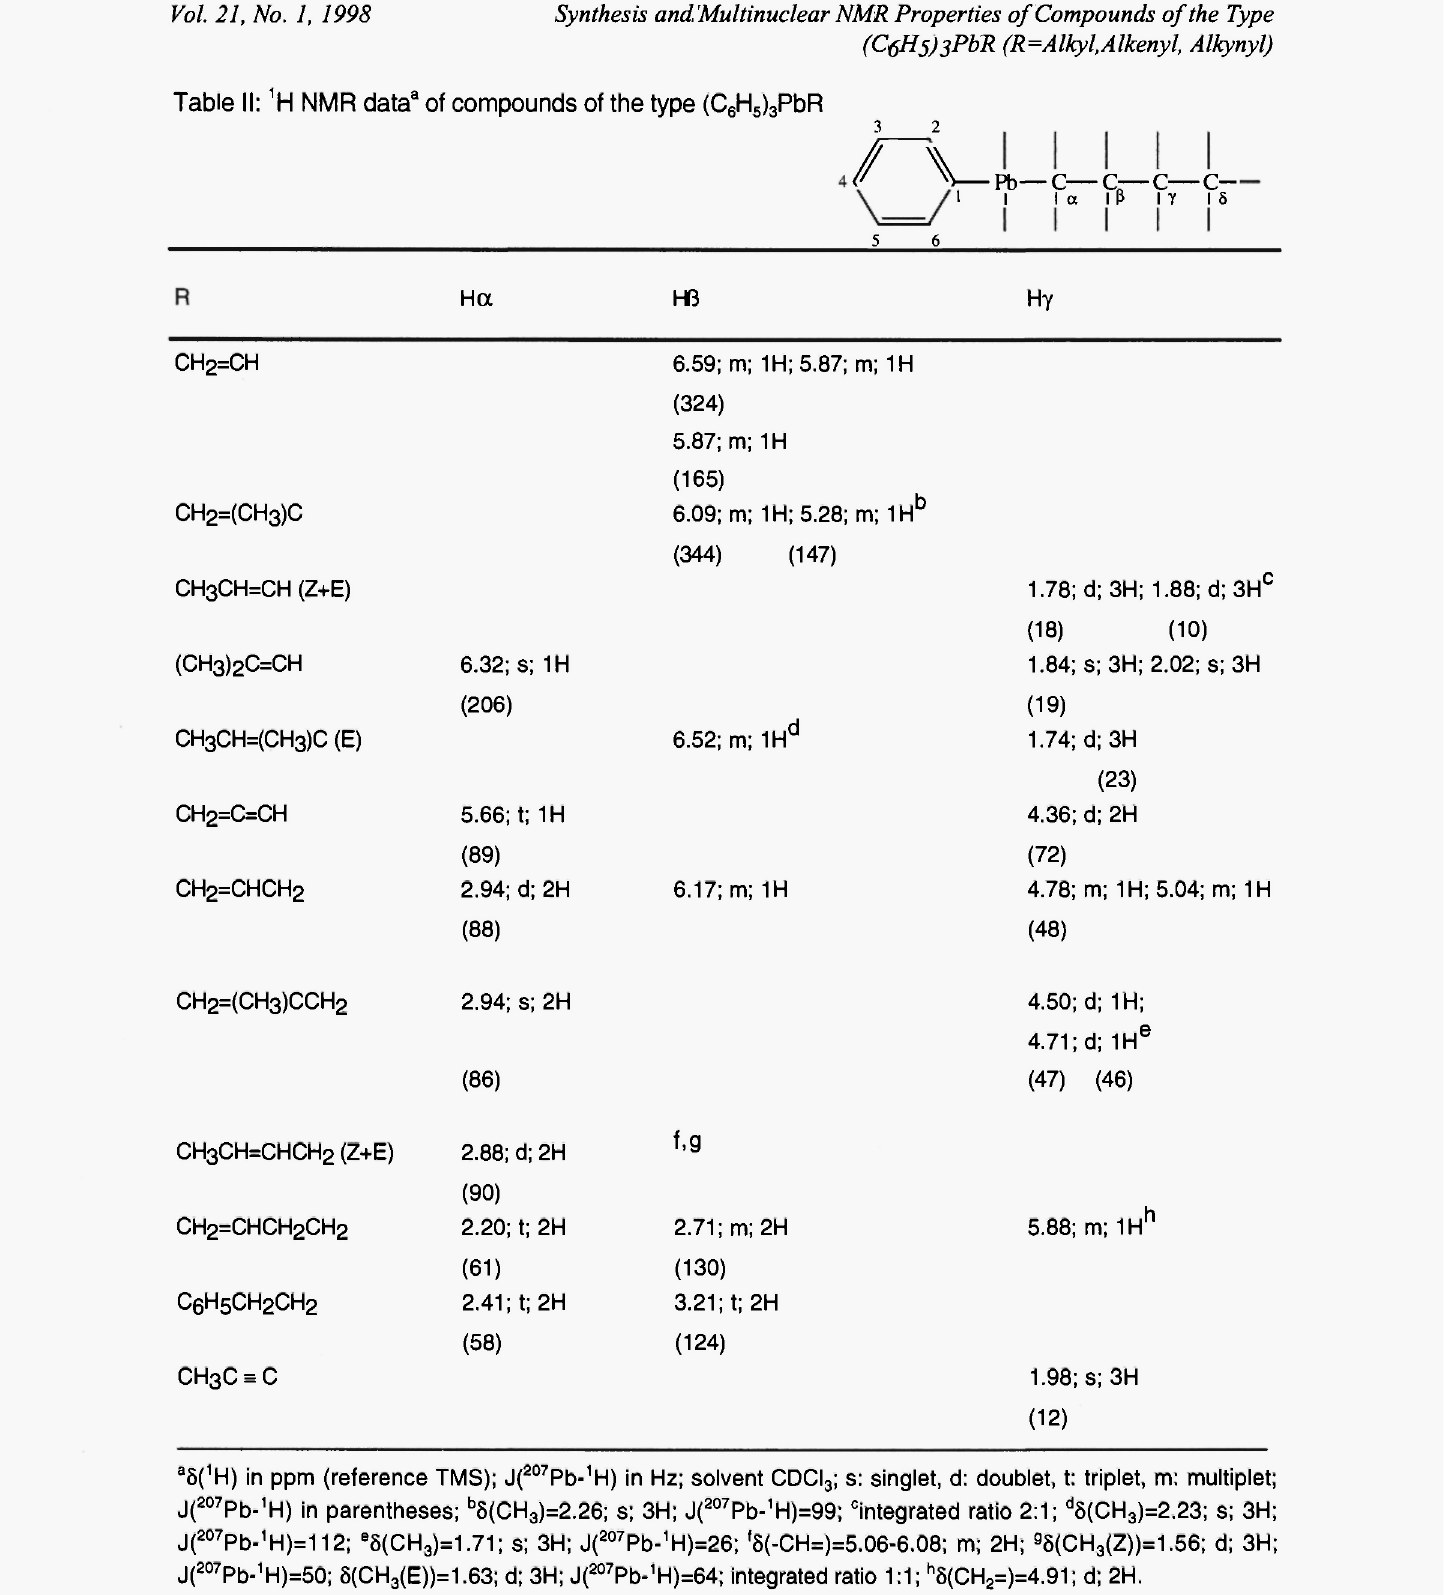
Table II: 1 H NMR data 3 of compounds of the type (C 6 H 5 ) 3